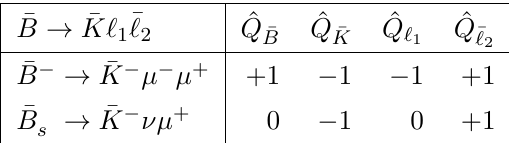
Table 1 . Example of charge assignment for FCNC and semileptonic decay which obey (2.14). Note that generally Q P = − Q ¯ , rules for the hatted charges are given in the text and by convention ¯ B P and ¯ K correspond to mesons with a b ¯ q and s ¯ q valence